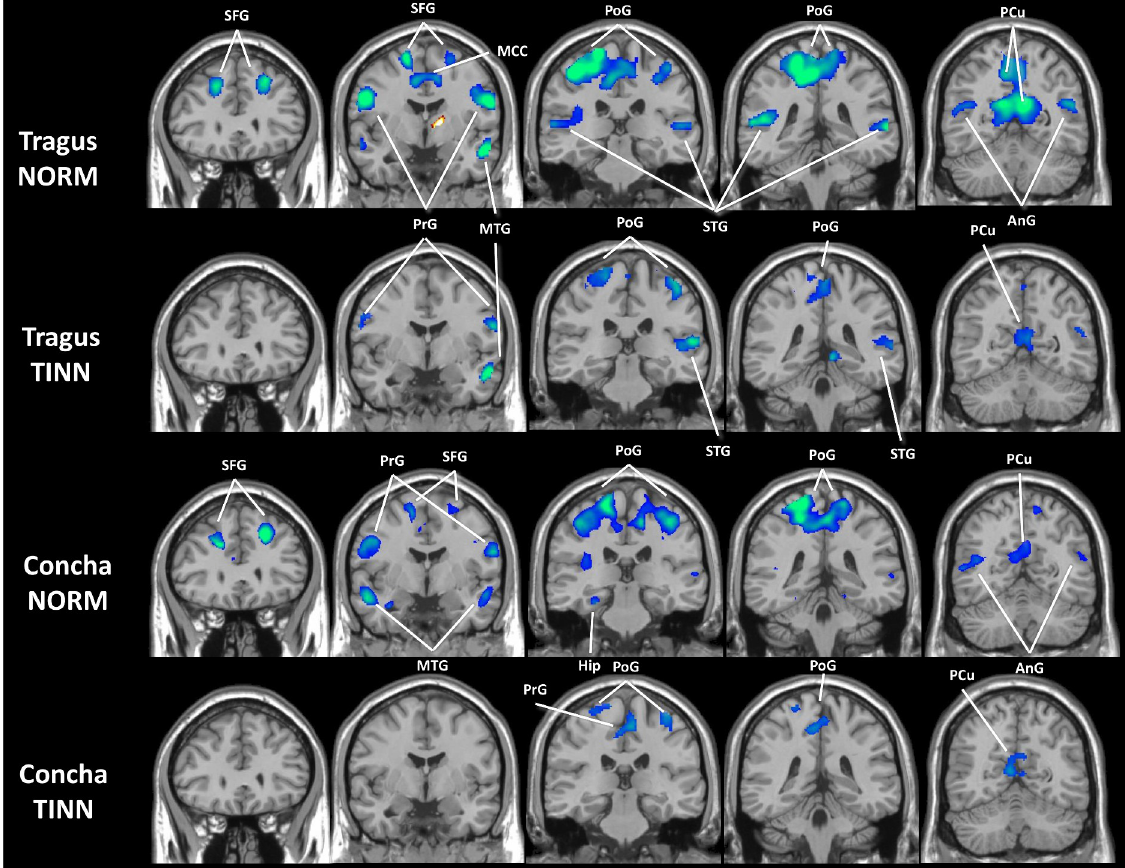
Fig 4. Activations (red) and deactivations (blue) induced by tVNS at the tragus and cymba conchae for NORM and TINN after matching the number of functional volumes (p < 0.05, cluster corrected for multiple comparisons). NORM: normal subjects; TINN: tinnitus patients; AnG: angular gyrus; CC: corpus callosum; Hip: hippocampus; MCC/PCC: middle/posterior cingulate cortex; MTG/STG: middle/ superior temporal gyrus; PCu: precuneus; PoG/PrG: postcentral/precentral gyrus; SFG: superior frontal gyrus.